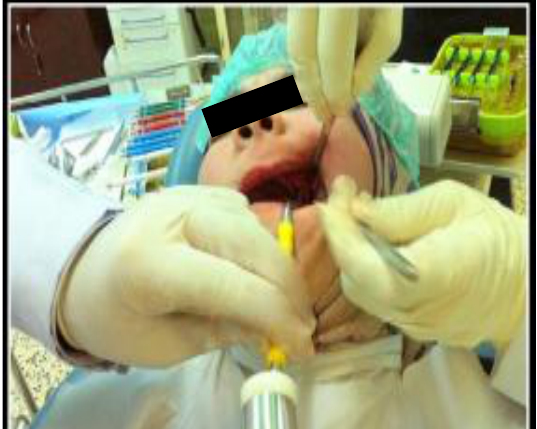
Figure 3: Controlled Green Stick Fracturing of the Sinus Floor with Osteotome. Depending on the residual alveolar bone height, the integrity of the Schneiderian membrane can be assessed clinically either by direct vision or by using hydraulic pressure test to elevate and detect the sinus membrane patency,